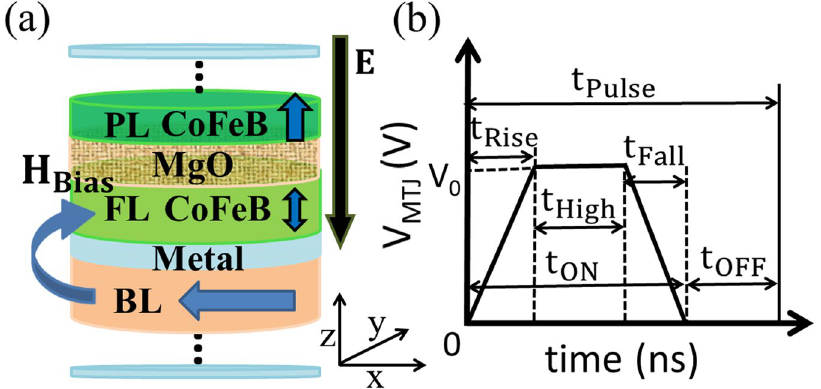
Figure 1. ( a ) Schematic of an elliptical pMTJ with the major axis along the x-axis. A bias layer (BL) separated by a metal is engineered to provide the exchange field for the FL. The top and bottom water-blue layers are electrodes. ( b ) Applied voltage pulse with t Rise = t Fall = 50 ps and t OFF of 10 ns, which is long enough to ensure that the magnetization is completely relaxed. Positive voltage is defined for the electric field pointing from the PL to the